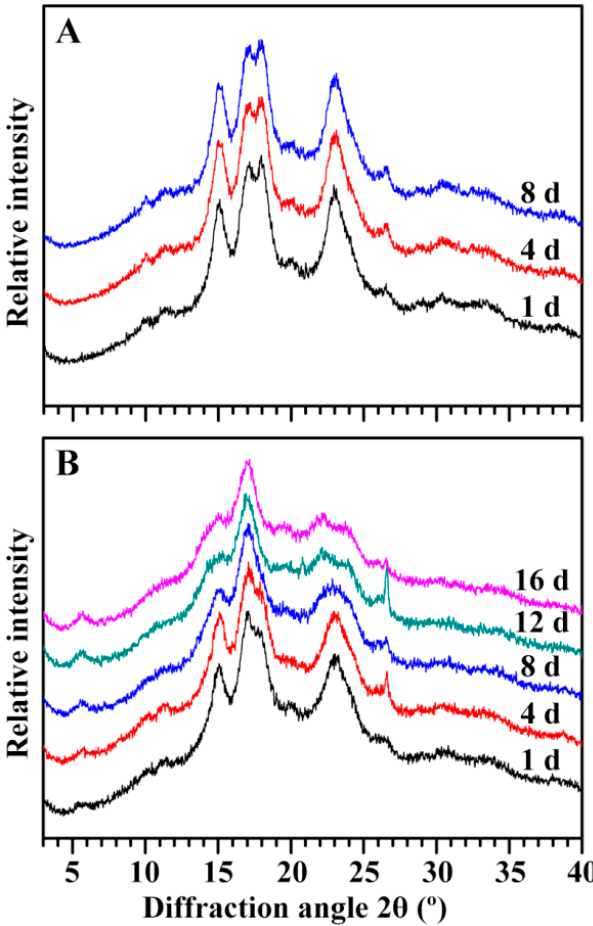
Int. J. Mol. Sci. 2018 , 19 , x Figure 11. The XRD pattern of endosperm starch during seedling growth. ( A ) GLXN, ( B ) GTR.